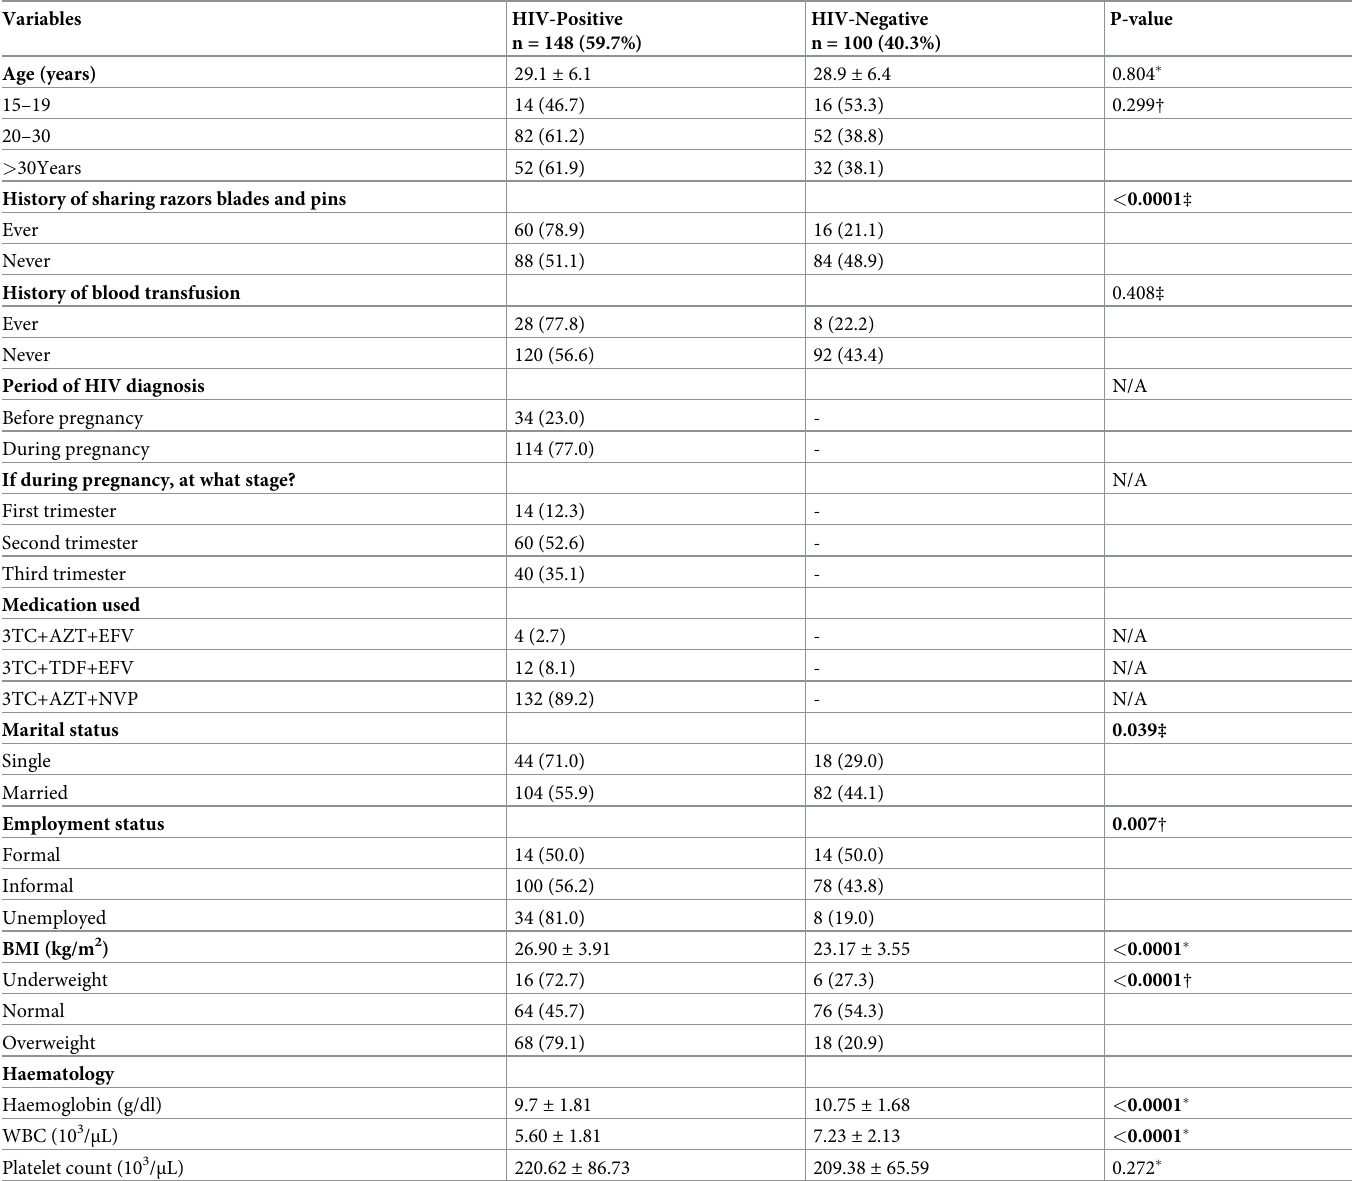
Table 1. Baseline characteristics of study